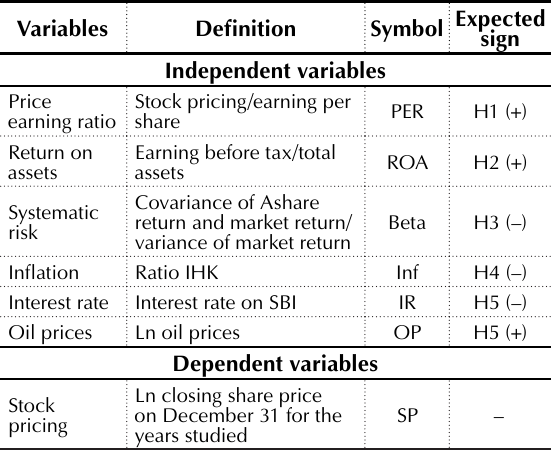
Table 1. Research variables and